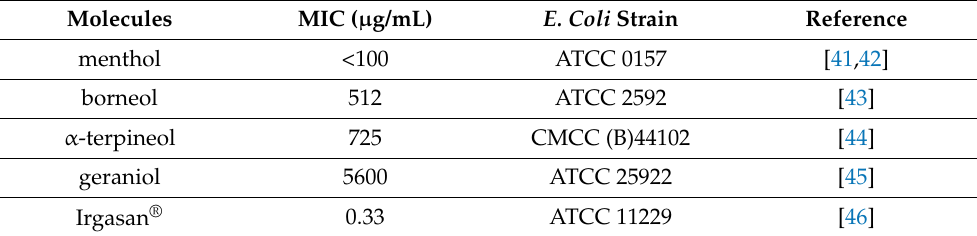
Table 1. Minimal inhibitory concentration (MIC) reported in the literature for the molecules used in this